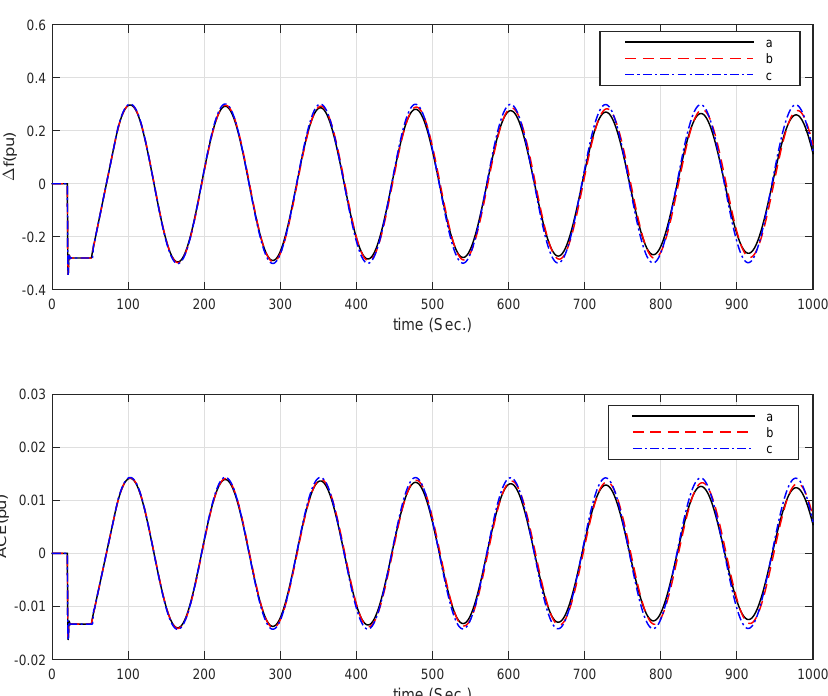
Figure 4. Frequency deviation and control error responses of one-area deregulated LFC scheme with K I = 0.05, h 1 ( t ) = 0 and different K P , h 2 ( t ) .